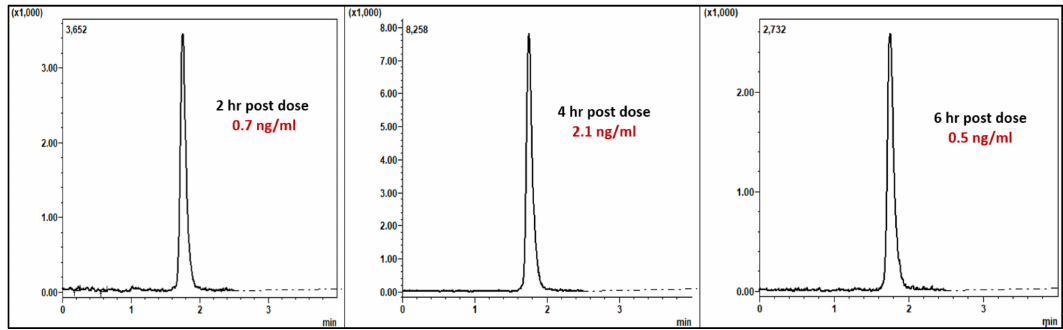
Figure 4. Chromatograms of COL detected in plasma after oral doses of COL at three time points from three rats. The volume assayed was 0.5 mL in these samples, to obtain information on the blood to plasma ratio in vivo.